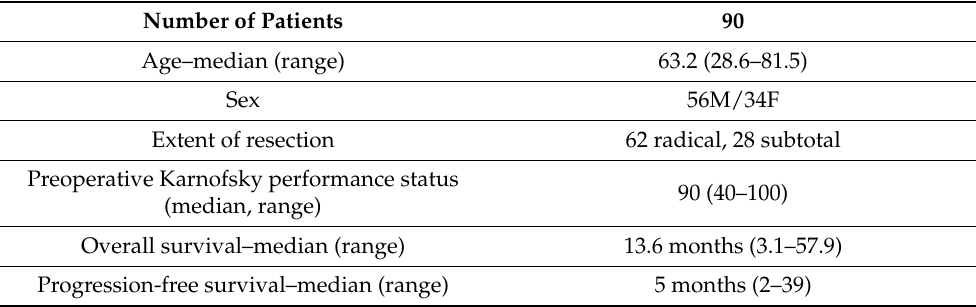
Table 1. Characteristics of glioblastoma patients evaluated in the survival